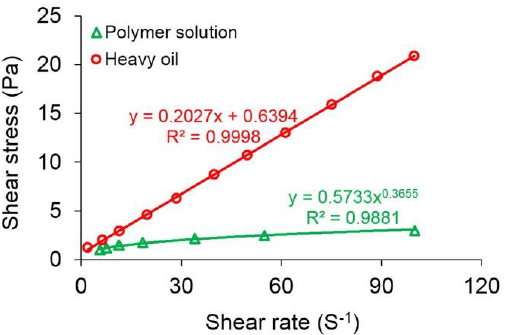
Figure 4. The rheological charts of the polymer solution with a concentration of 2000 mg/L and the original heavy oil.